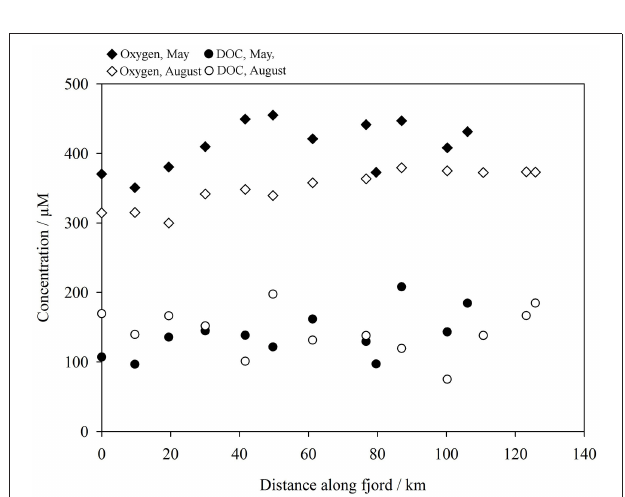
FIGURE 5 | Dissolved oxygen (diamonds) and dissolved organic carbon (DOC, < 0.2 µ m, circles) in the surface waters of Godthåbsfjord, May (closed shapes) and August (open shapes) 2014. Plotted as distance from GF2.